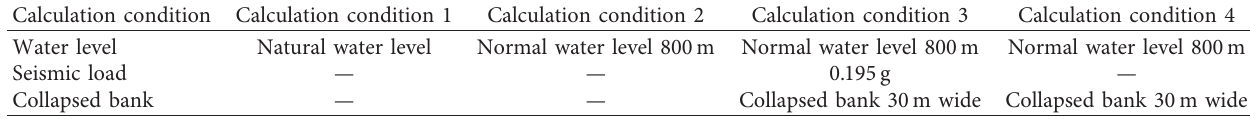
Table 8: Calculation conditions of the landslide.